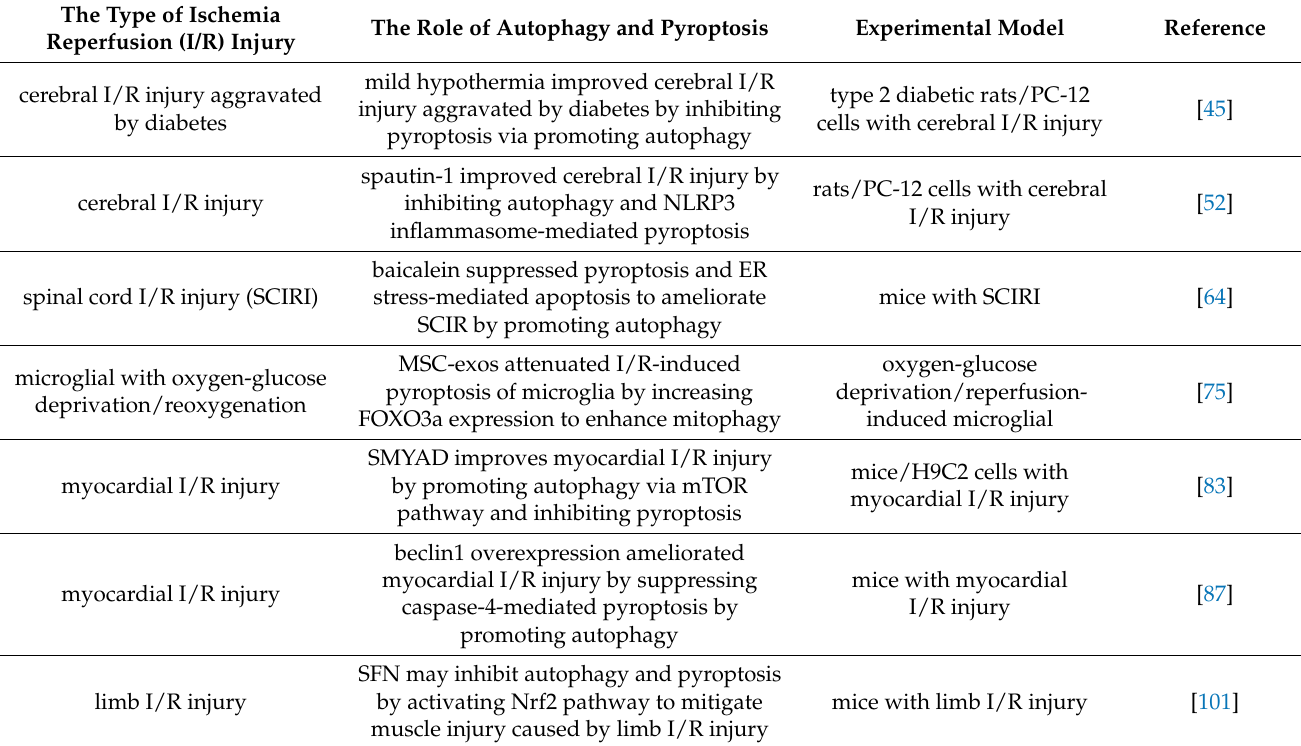
Table 1. The summary of the role of autophagy and pyroptosis in ischemia reperfusion (I/R)